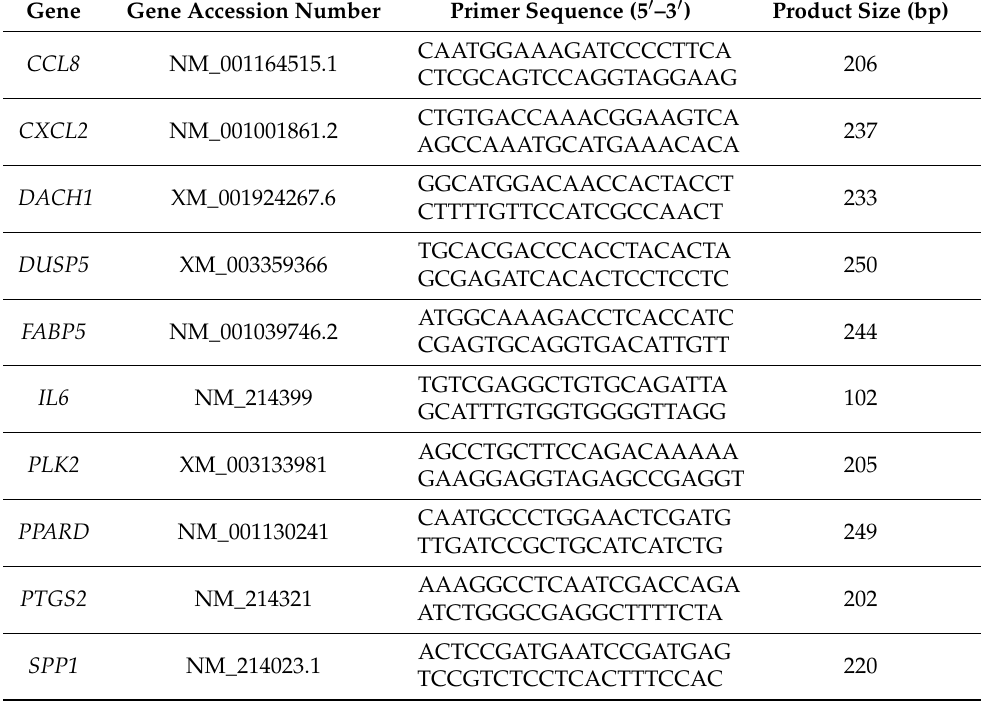
Table 1. The sequences of RT-qPCR analysis